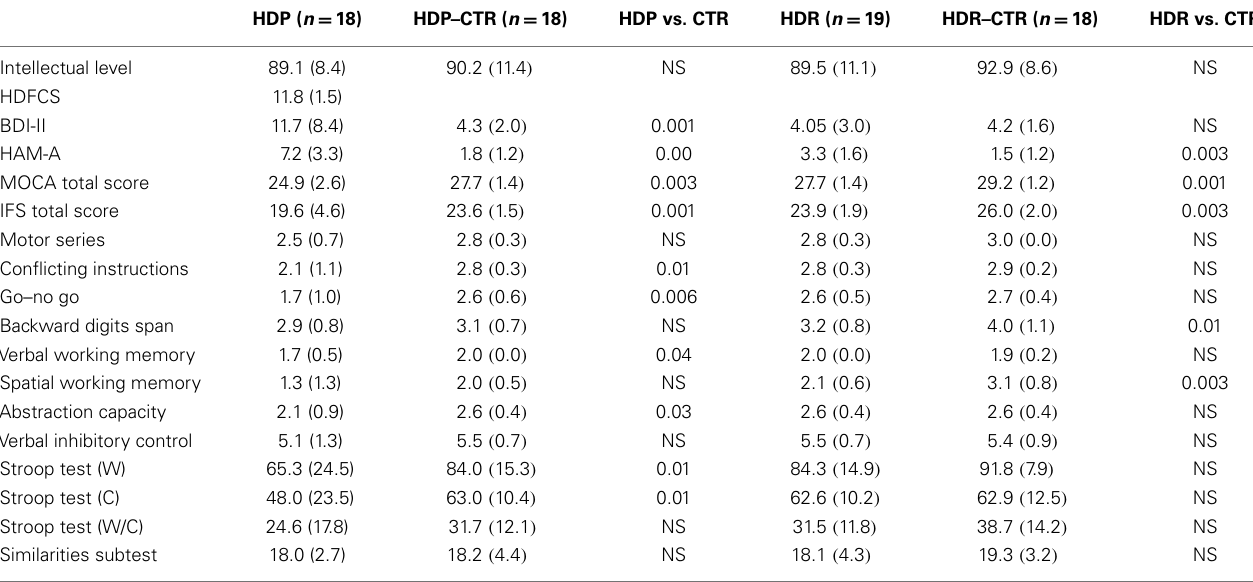
Table 2 | Psychopathological and neuropsychological data